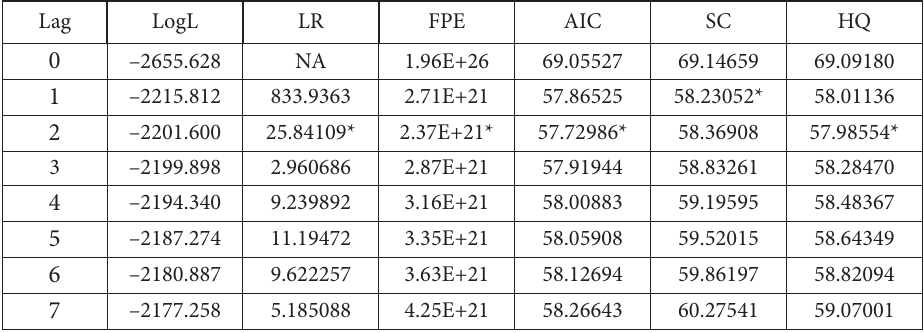
Table A1. Lag length criteria in the case of the model for Romania (source: authors’ calculations)